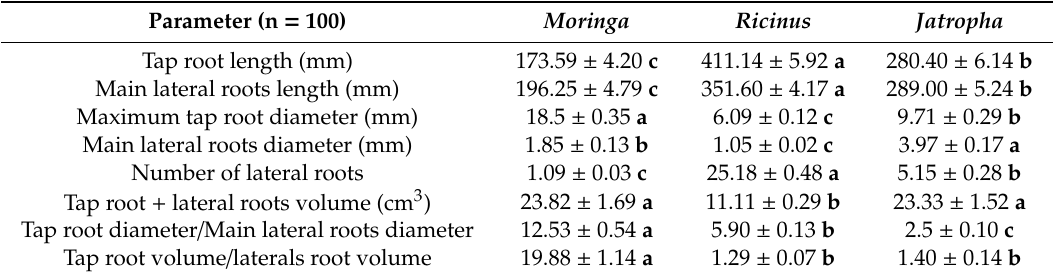
Table 3. Average root dimensions ± SE of 63-day-old Moringa oleifera , Jatropha curcas , and Ricinus communis